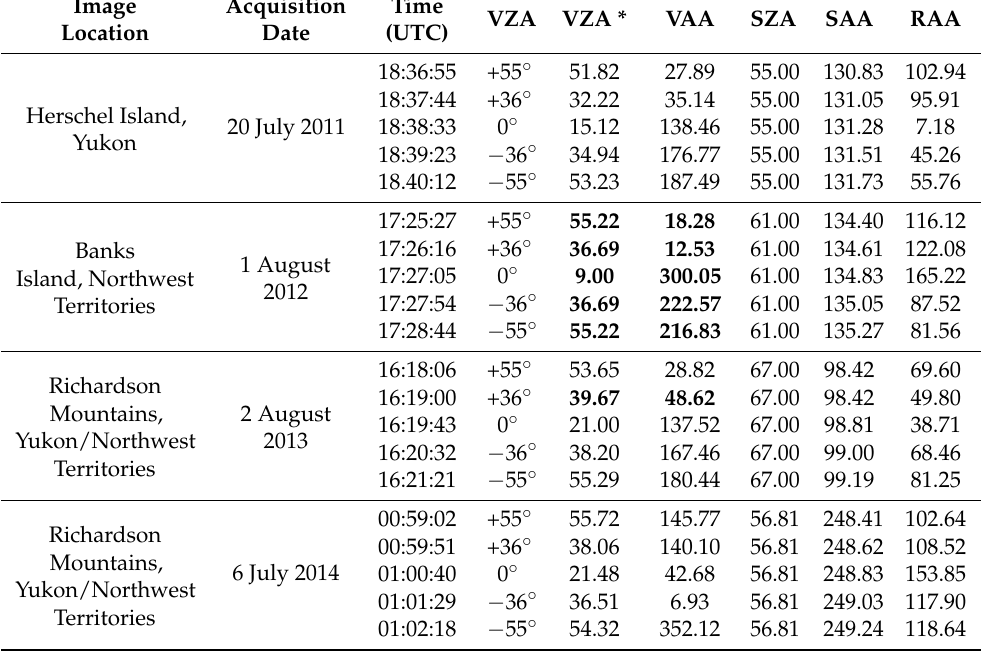
Table 1. CHRIS imagery timing and solar/viewing angles. Bolded values were estimated or corrected from the metadata delivered with the images. Acronyms are: view zenith angle (VZA), view azimuth angle (VAA), sun zenith angle (SZA), sun azimuth angle (SAA) and relative azimuth angle (RAA; the angular azimuth difference between the sun and sensor). It should be noted that the theoretical VZA and actual VZA (denoted with a *) differ. Acquisitions are in Coordinated Universal Time